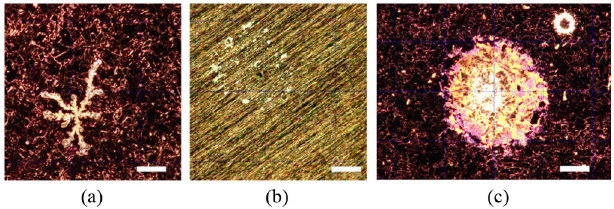
FIG. 5. Examples of breakdown damage on Be and Cu plates, observed after zero- and three-tesla runs, via digital microscopy. No new damage was evident on Be surfaces after three-tesla runs, so no images of this damage type are available. The white scale bar denotes 250 μ m in all cases. (a) Damage on Cu from zero- tesla run; (b) Damage on Be from zero-tesla run; (c) Damage on Cu from three-tesla run.